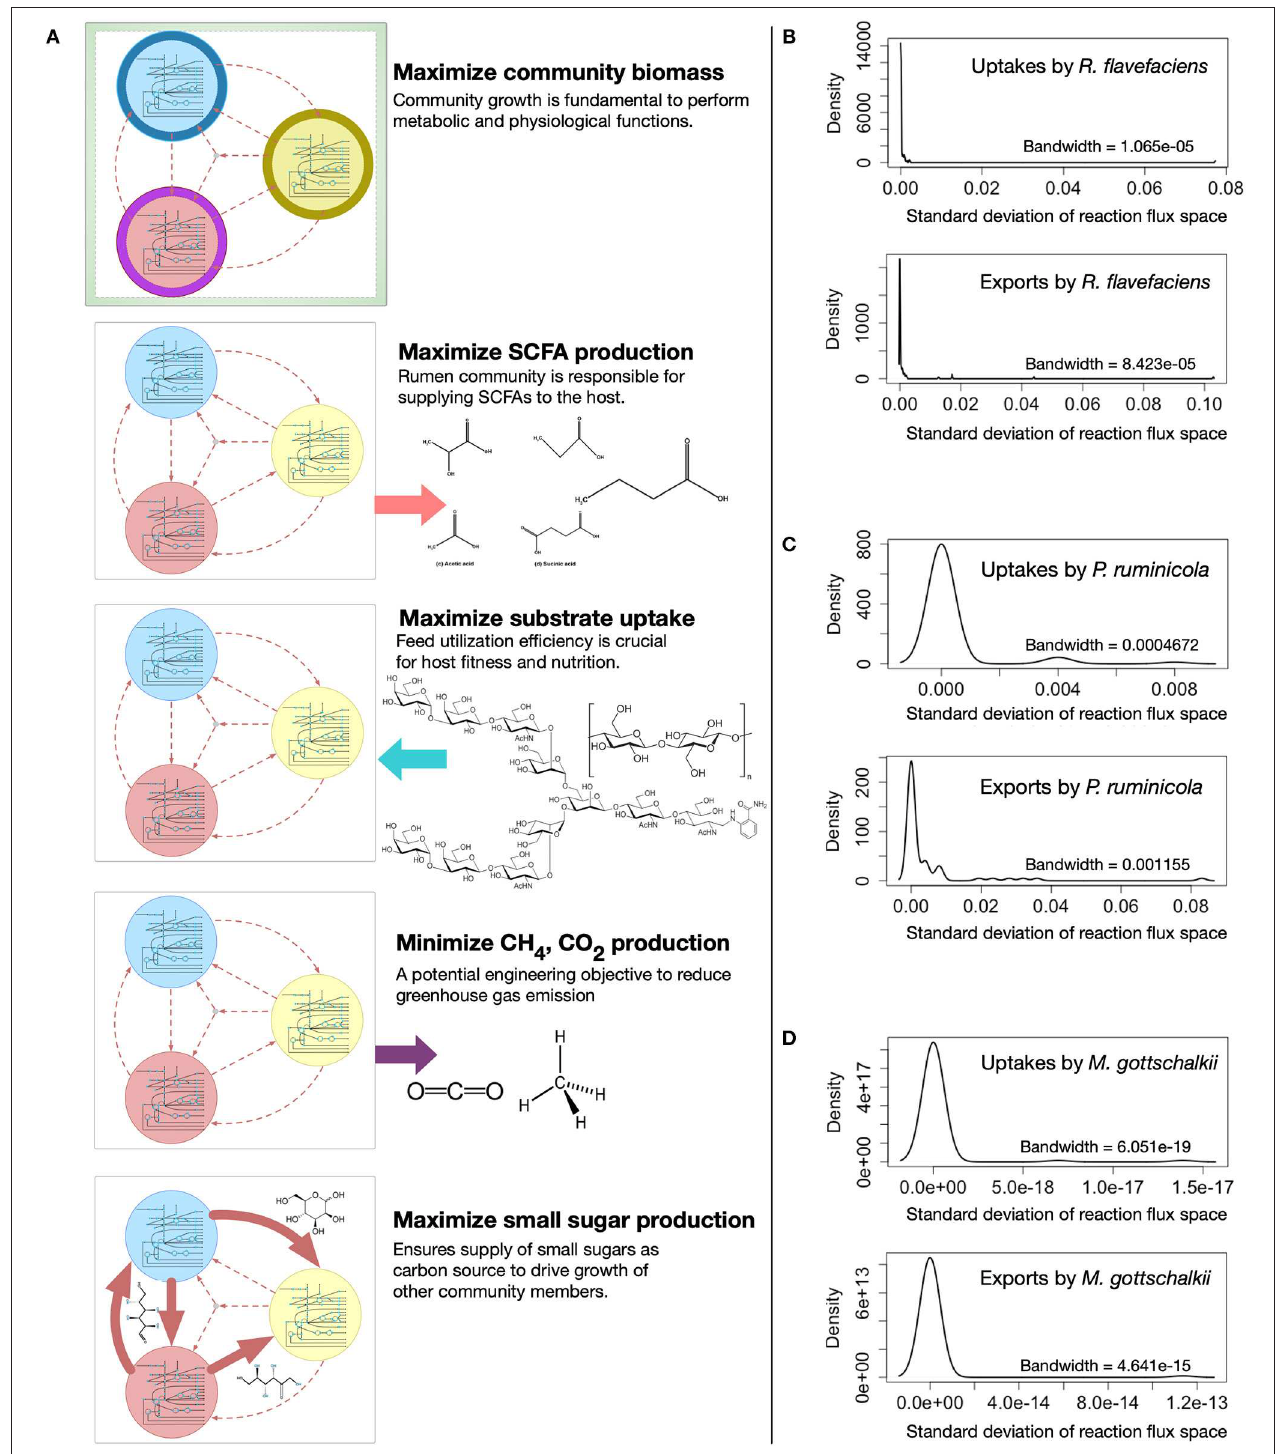
FIGURE 4 | Variability in metabolic fluxes under different community objective functions. (A) Visual representation showing the choice of different community-level objective functions. The density functions (right) show the insignificance of the variations in exchange flux space upon optimizing for different objective functions, i.e., maximizing total community biomass, maximizing total Short-chain Fatty Acids (SCFA) production, maximizing total complex carbohydrate uptake, minimizing total Methane and carbon-di-oxide production, and maximizing total sugar production by the community: (B) R. flavefaciens , (C) P. ruminicola , and (D) M. gottschalkii . The bandwidth is the standard deviation of the smoothing kernel of the density